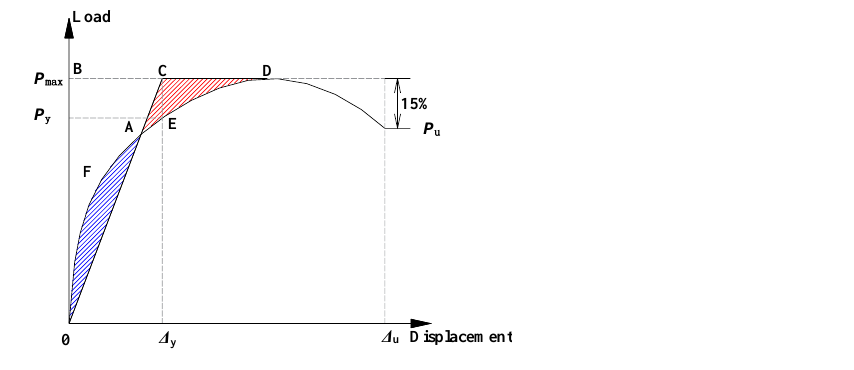
Table 3. Analysis parameters and calculation results of seam location.